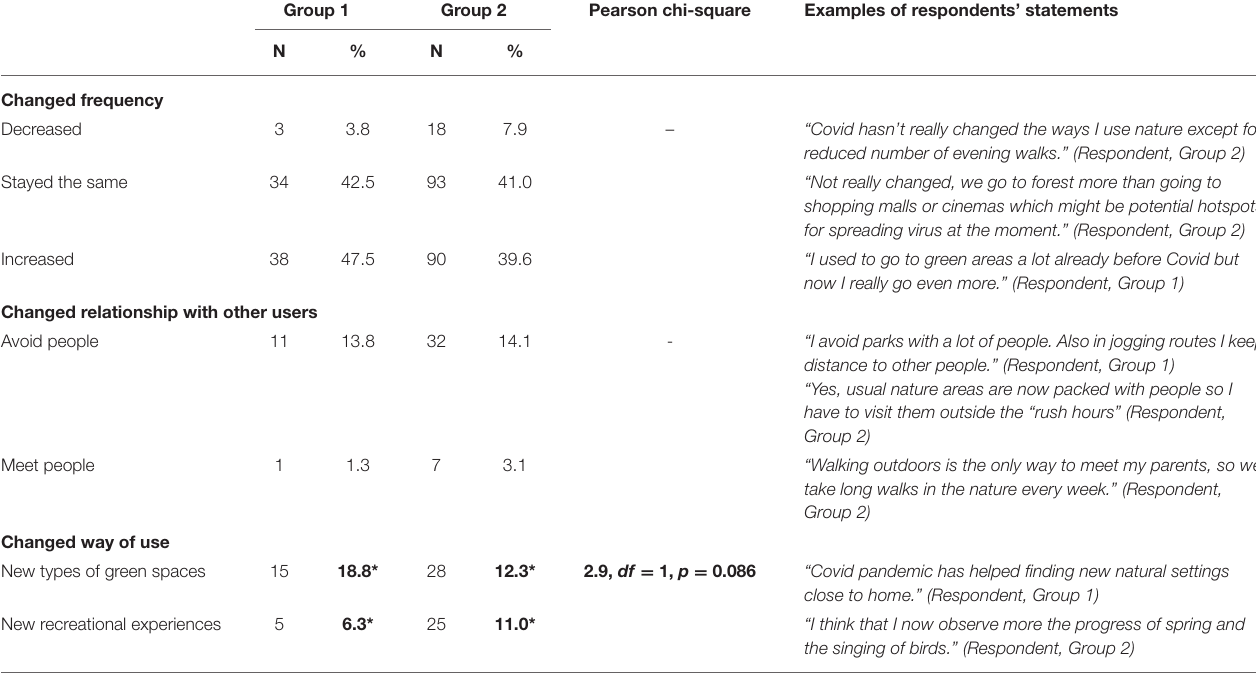
TABLE 4 | Reported changes in green space use among respondents in Group 1 and Group